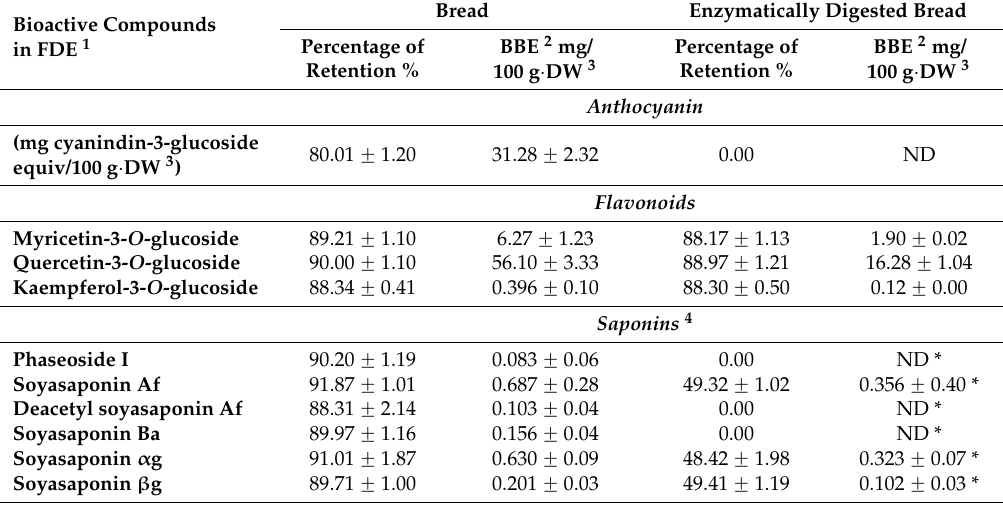
Table 2. Quantification of bioactive compounds in breads and enzymatically digested breads with and without the supplementation of black bean seed coat